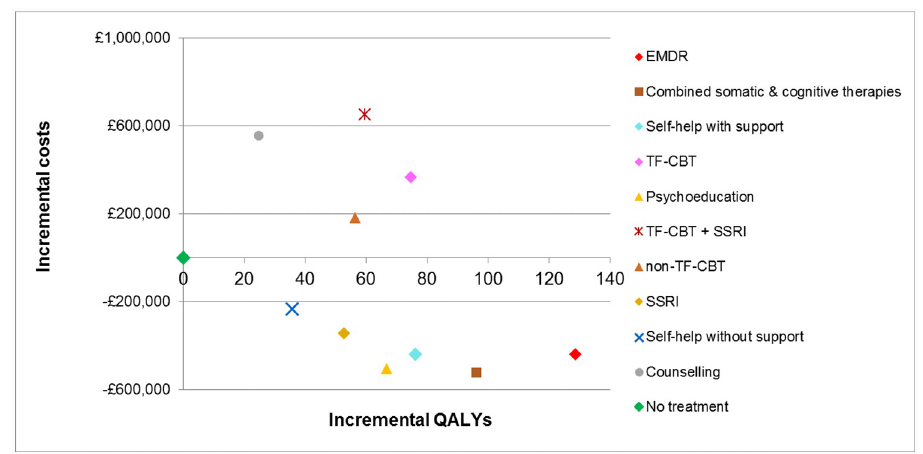
Fig 2. Cost-effectiveness plane: Base-case analysis results for 1,000 adults with PTSD.